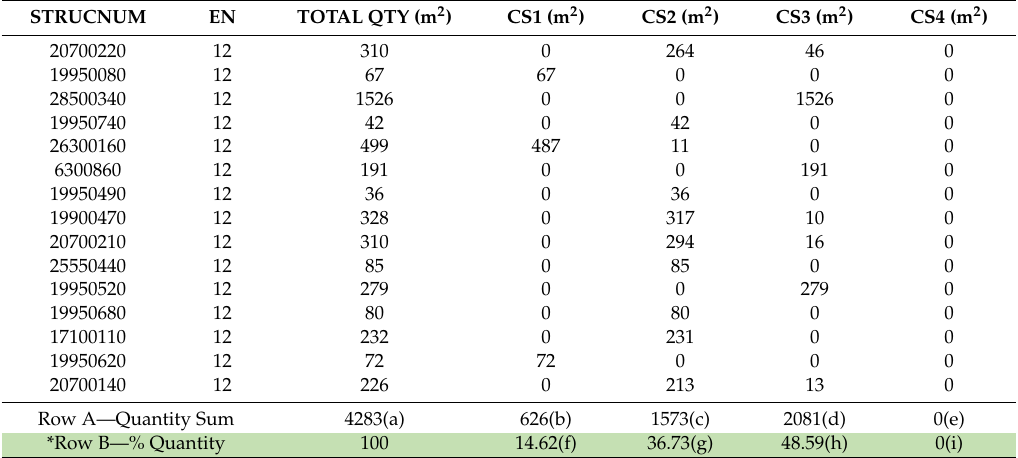
Table 1. A typical element-level inspection in Georgia (reinforced concrete deck for age bin 1940).